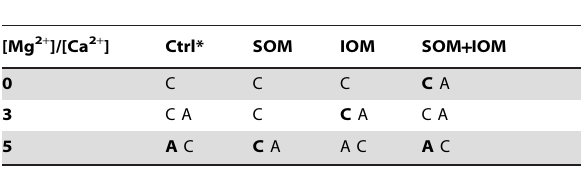
A and C indicate aragonite and calcite, respectively. When two phases are obtained the main phase is indicated in bold. # # The reported data represent the trend observed from more than 10 independent replica of crystallization experiments using different batches of OM fractions. The presence of ACC is not indicated. *Ctrl indicates mineralization experiment conducted in the absence of organic matrix.